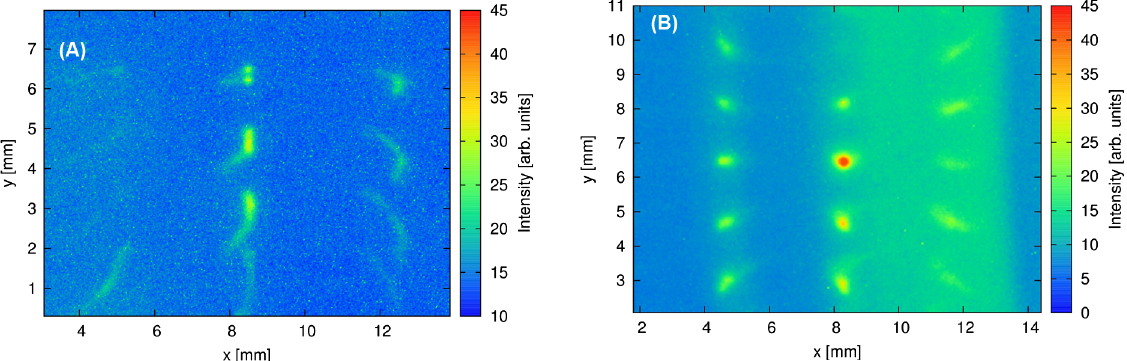
¼ 0 : 4 mm mrad and the high-charge regime, n